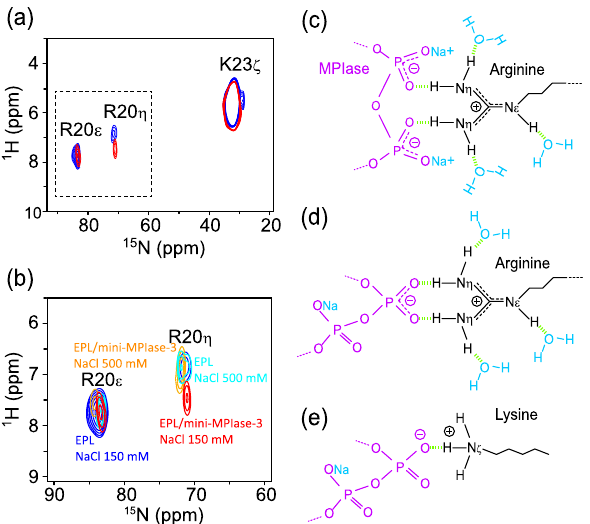
Figure 5. ( a ) Arg and Lys side chain signal regions of the 2D 1 H- 15 N FSLG-HETCOR spectrum of Pf3_27 (Fig. 1d) in EPL membranes in the absence (blue) and presence (red) of mini-MPIase-3 at 10 °C. The area surrounded by a dashed line is expanded in ( b ). ( b ) Close-up of Arg side chain NH η and NH ε signal regions of 2D 1 H- 15 N FSLG-HETCOR spectra of 15 N-labeled Pf3_27 at R20, K23 in the EPL (blue) and EPL/2 mol% mini-MPIase-3 (red) membrane with 150 mM NaCl, and the EPL (light blue) and EPL/2 mol% mini-MPIase-3 (orange) membrane with 500 mM NaCl at 10 °C. ( c – e ) Schematic models of Arg ( c and d ) or Lys ( e ) side chain (black) interaction with the pyrophosphate linker part of MPIase (purple). Light green dots show hydrogen